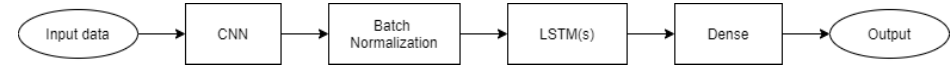
Figure 2. Scheme for the layers in the BioECG classification